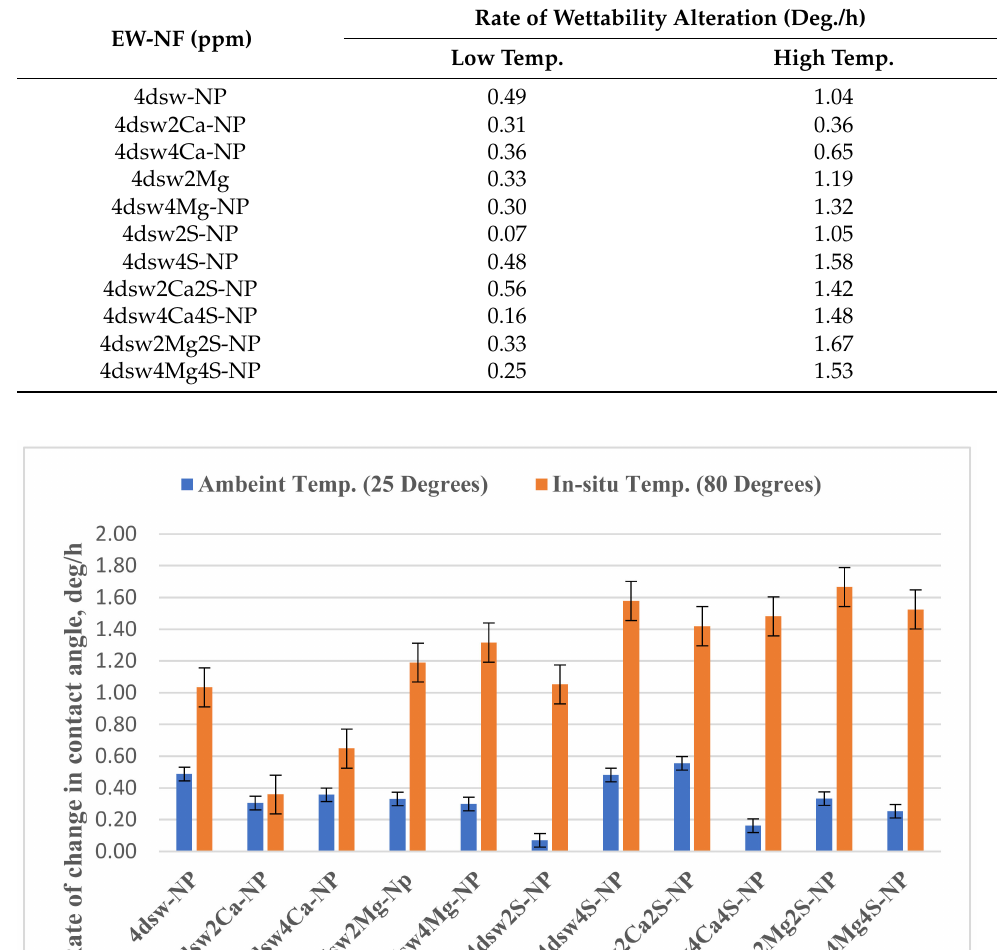
Table 5. Rate of change and acceleration of contact angle at different temperatures.